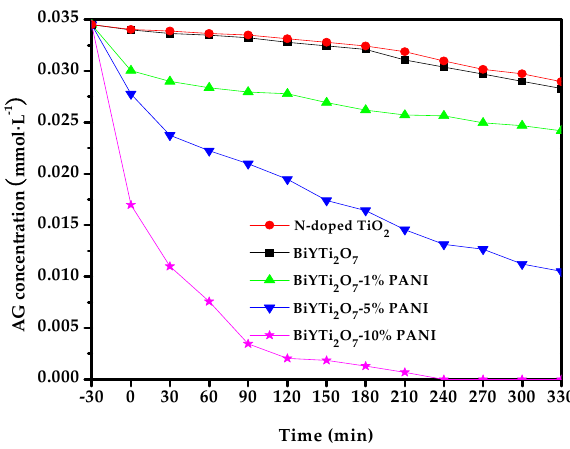
Figure 13. Photocatalytic degradation of AG under visible light irradiation in the presence of different PANI-modified BiYTi 2 O 7 photocatalysts and N-doped TiO 2 .